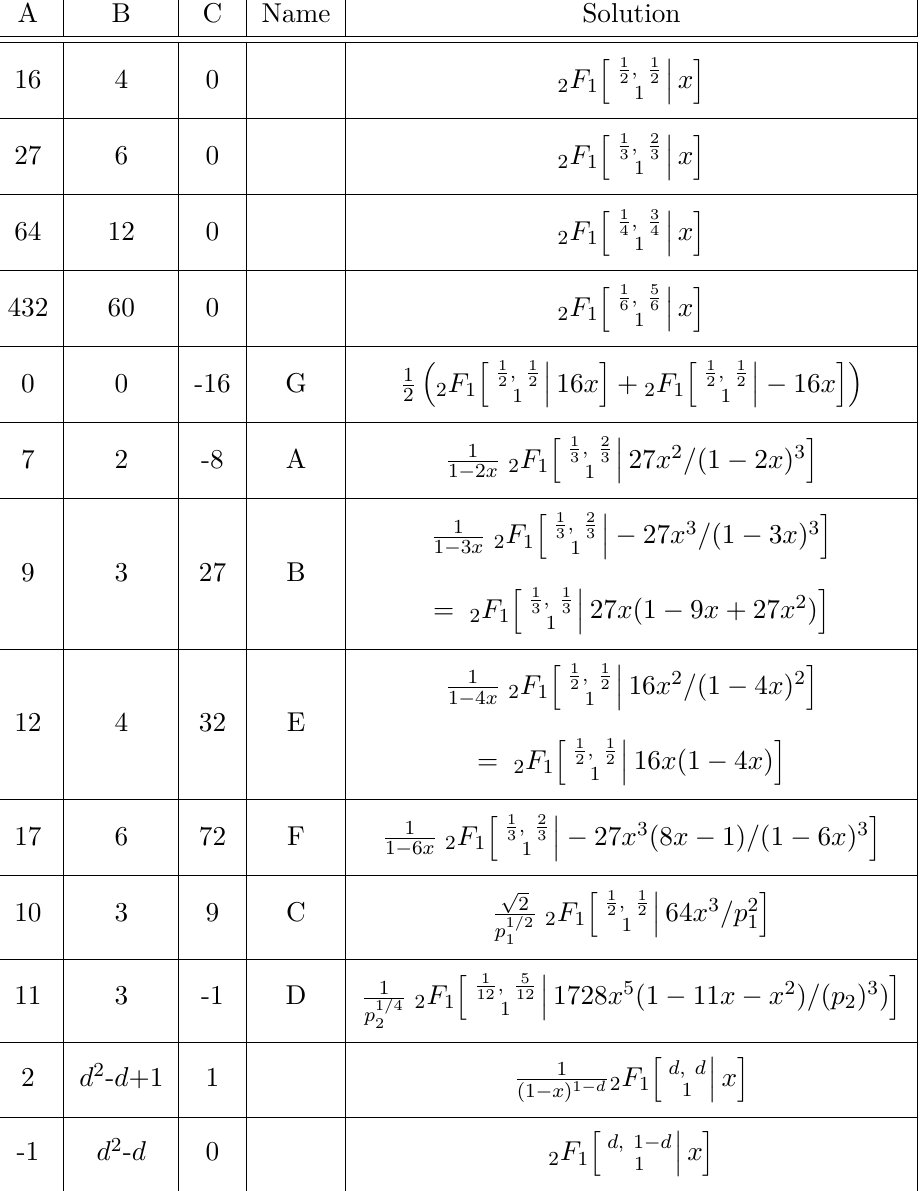
Table 1 . Solutions to Apéry-like recursions (3.5). Note that the 2 F 1 D is related to all of the cases A-F in terms of Möbius